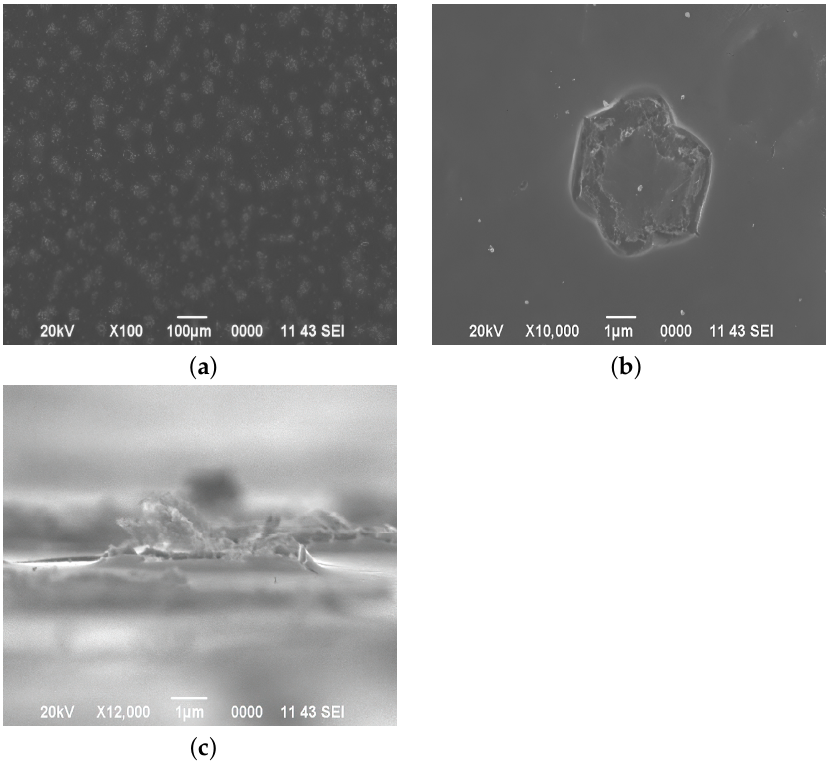
Figure 2. The surface morphology of films deposited from a film-forming system with pH = 1.42. Top